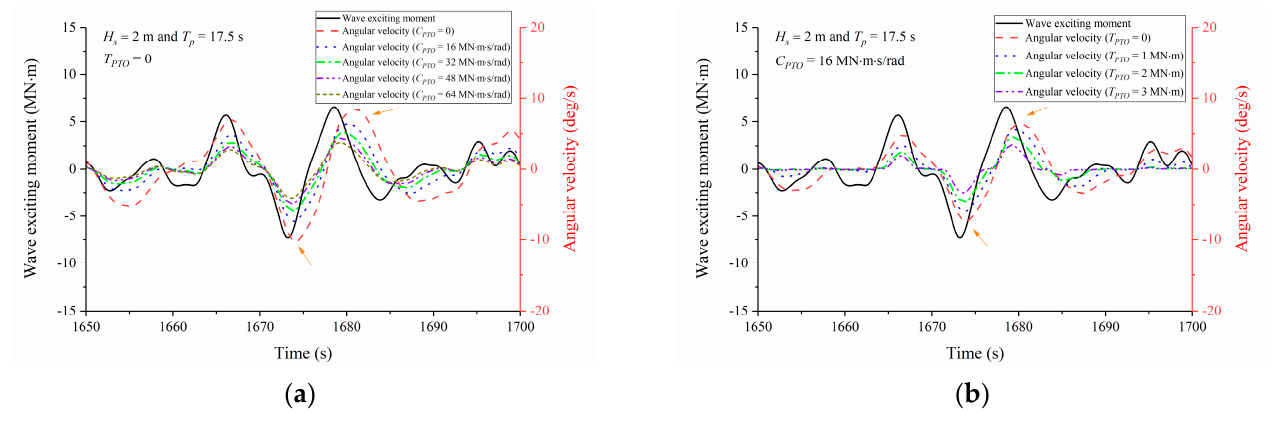
Figure 28. The CWRs of a no-friction flap ( 𝑇 (cid:3017)(cid:3021)(cid:3016) = 0 ) for various values of PTO damping 𝐶 (cid:3017)(cid:3021)(cid:3016) under modified irregular waves of 𝐻 𝑠 = 2 m in 12.5 m-deep water.